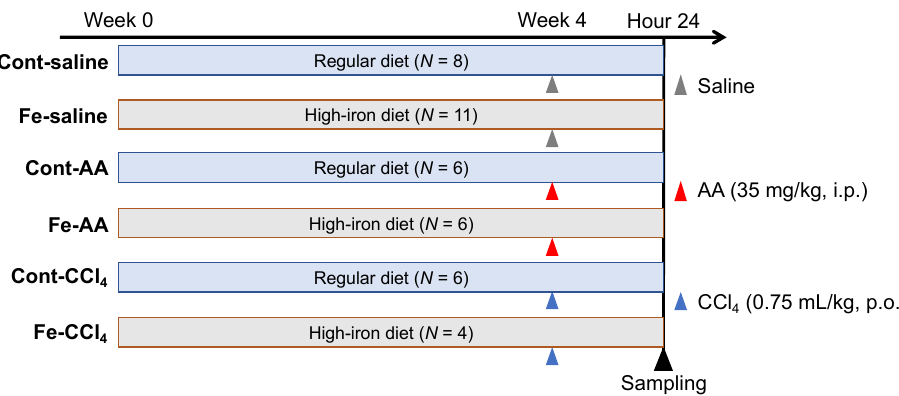
Figure 1. Experimental design of this study. AA; allyl alcohol, CCl 4 ; carbon tetrachloride.